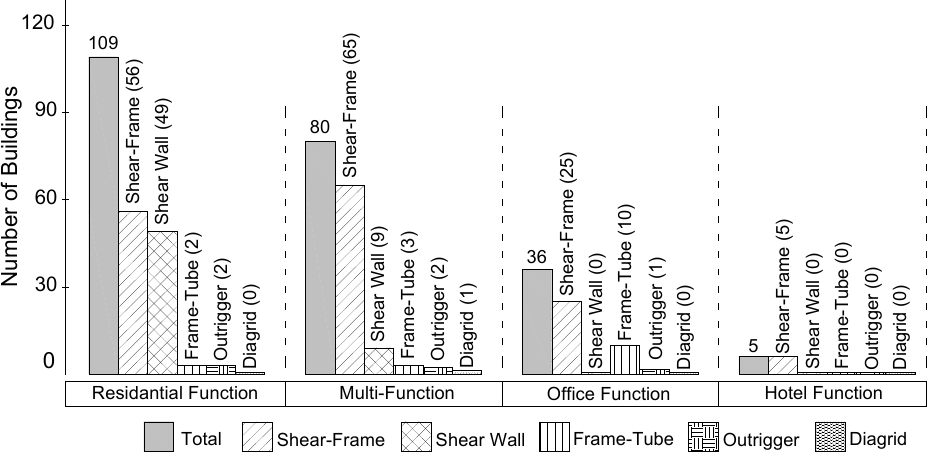
Figure 16 illustrates the functions of tall buildings and the number of structural sys- tems used in these functions. The grey bars on the left axis of the graph demonstrate the total number of tall buildings.